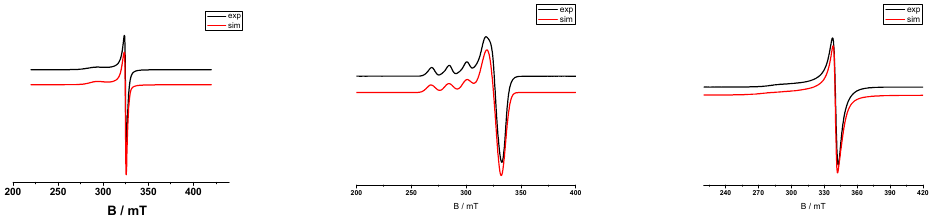
Figure 4. Room temperature solid-state spectra of 1 , 3 and 4 . Simulated spin Hamiltonian parameters are g ⊥ = 2.082, g ‖ = 2.290 and ∆ B = (1.2, 8.5) mT ( 1 ); g ⊥ = 2.063, g || = 2.305, A ‖ = 16.2 mT and ∆ B = 4 mT ( 3 ); and g ⊥ = 2.055, g ‖ = 2.308, A ‖ = 16 mT and ∆ B = (1.3, 8) mT ( 4 ). Table 3. EPR spectral parameters of powders measured at RT and frozen DMSO solutions measured at 100 K.